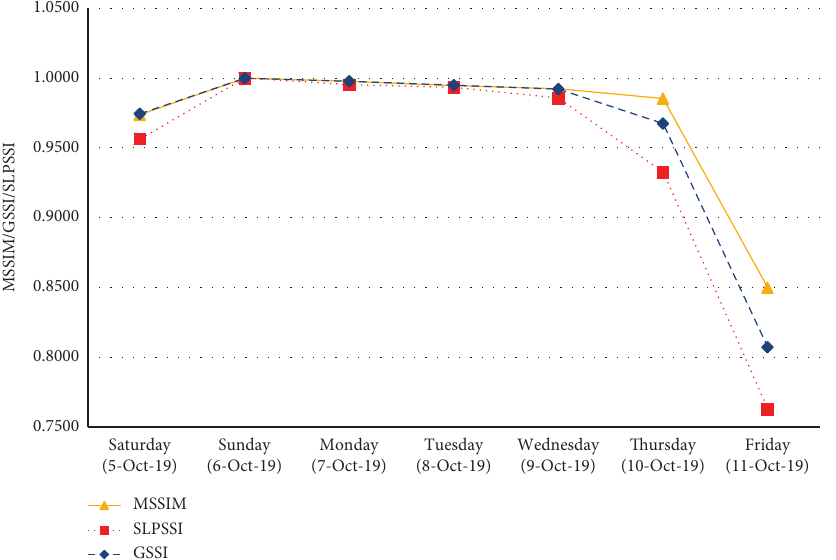
Figure 12: Comparison between daily matrices and the matrix of Sunday based on the GSSI, MSSIM, and SLPSSI methods.